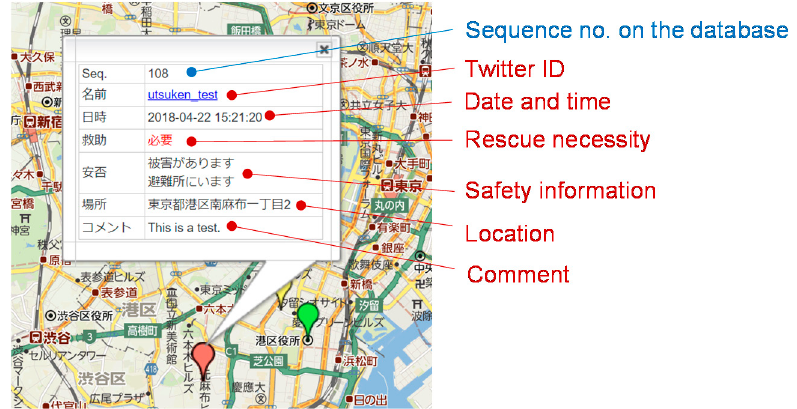
Figure 12. Safety information displayed on the list and map view page for the supporting users.